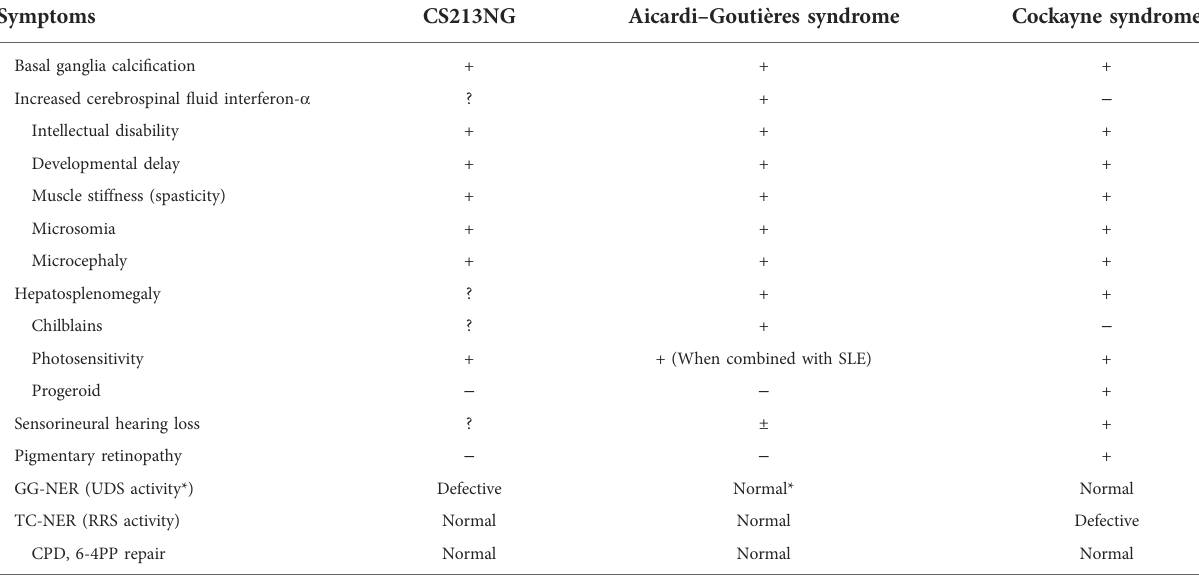
TABLE 1 Common clinical manifestations in Aicardi – Goutières syndrome and cockayne syndrome, and symptoms observed in the present patient